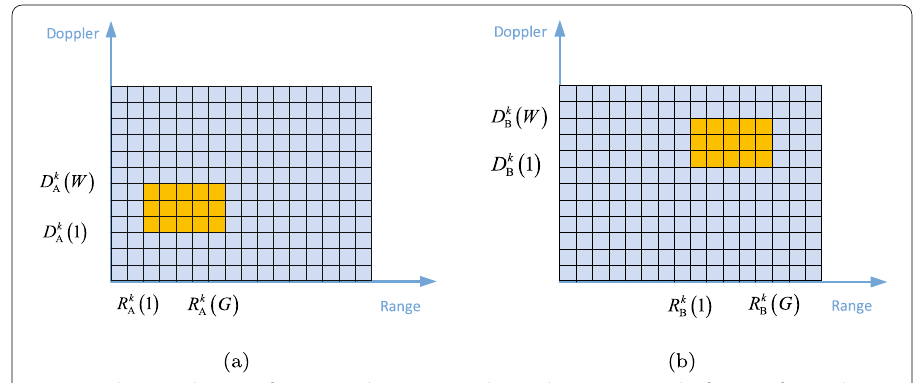
Fig. 5 A schematic diagram of censoring data using initial CFAR detection a signals after MTD from radar A in the k -th CPI b signals after MTD from radar B in the k -th CPI: The blue cells represent all the data after MTD. The yellow cells represent the data after the initial CFAR. For radar A, R k A ( 1 ) , R k A ( G ) are the starting and ending indexes of censored cells in range dimension, and D k A ( 1 ) , D k A ( W ) are the starting and ending indexes in Doppler dimension. For radar B, R k B ( 1 ) , R k B ( G ) are the starting and ending indexes of censored cells in range dimension, and D k B ( 1 ) , D k B ( W ) are the starting and ending indexes in Doppler